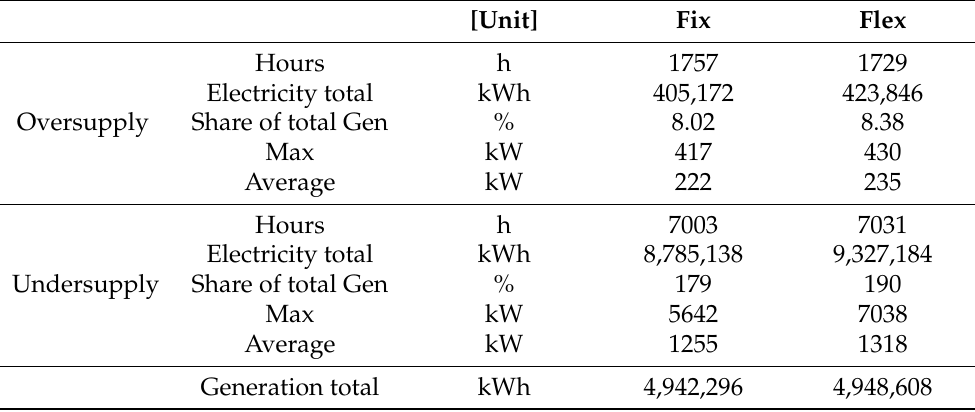
Table 8. Market results of product “Grey